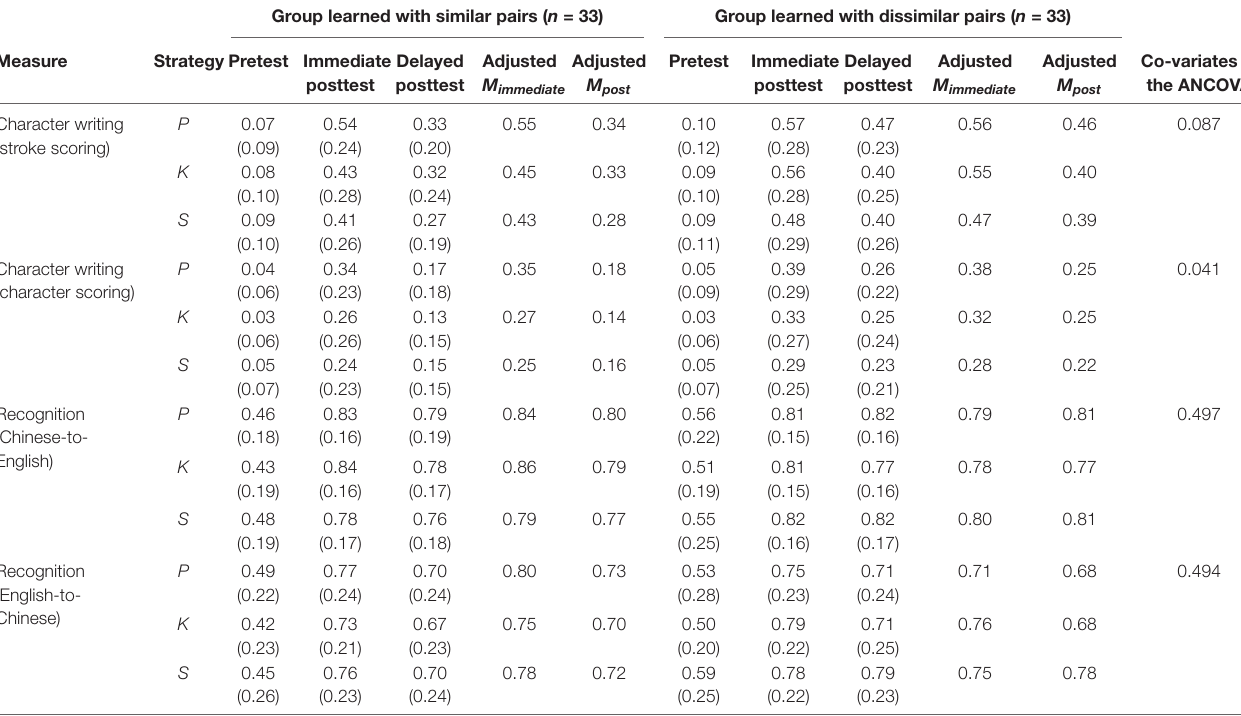
TABLE 3 | Descriptive statistics ( M , standard deviation, and the adjusted M ) of the two groups for all learning measures over time ( N = 66). Group learned with similar pairs ( n = 33) Group learned with dissimilar pairs ( n = 33)